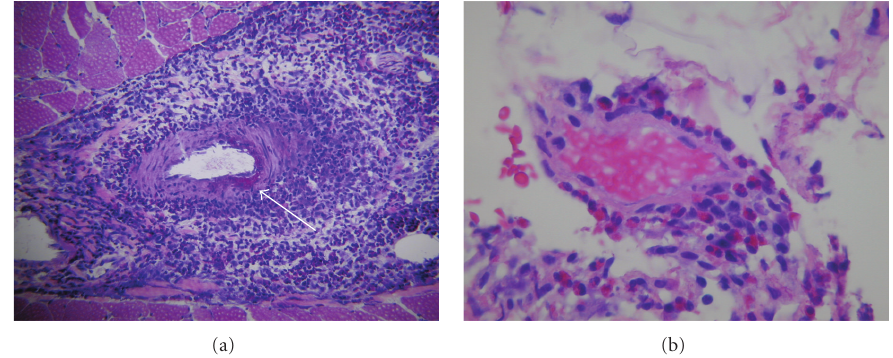
Figure 1: Case 1 (A and B). (a) Cryostat section of quadriceps muscle stained with hematoxylin and eosin demonstrates a severe necrotizing vasculitis of an intramuscular arteriole. Intramural fibrinoid necrosis is evident (arrow). Surrounding the vessel are large numbers of macrophages, lymphocytes, and eosinophils (original magnification 100x). (b) High-magnification image of formalin fixed, para ffi n-embedded tissue with an intramuscular vessel demonstrating large numbers of intramural and perivascular eosinophils (original magnification 400x).